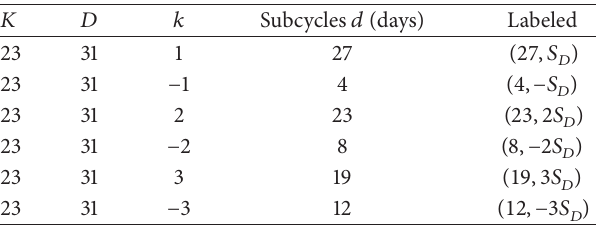
Table 2: Subcycles for a RGT orbit of which the parameter 𝑄 = 14+ 23/31 .